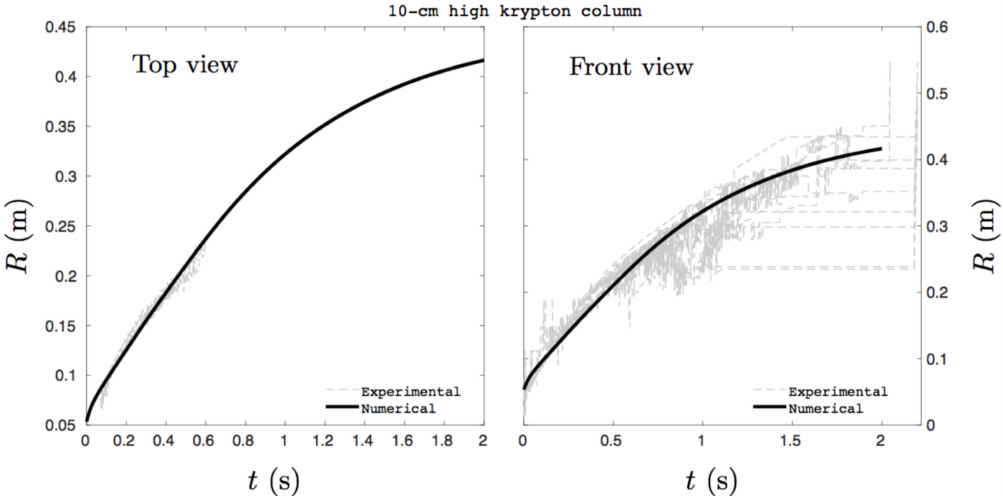
Figure 10. Temporal evolution of the krypton front position. Comparison of the one-dimensional solution of the present two-layer shallow water model versus experimental data. The initial krypton column is 10-cm high. Computed results are in good agreement with experimental